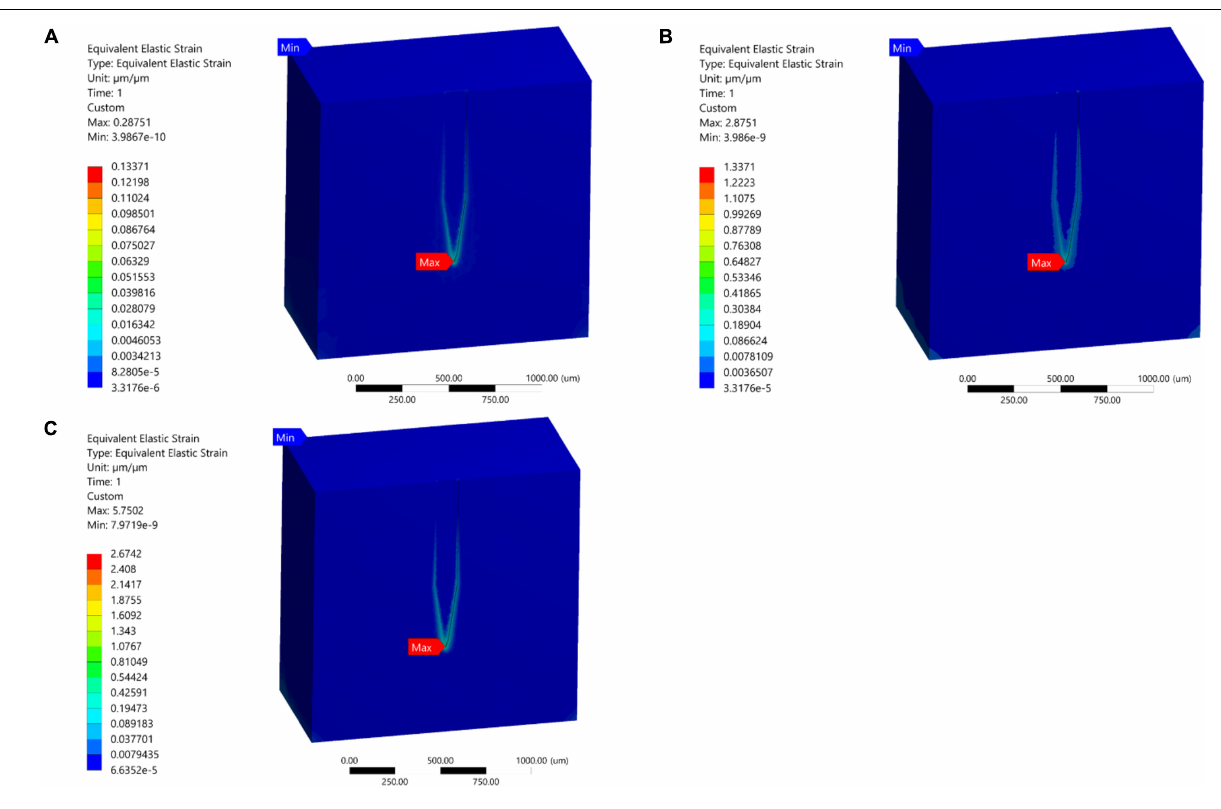
Frontiers in Neuroscience |